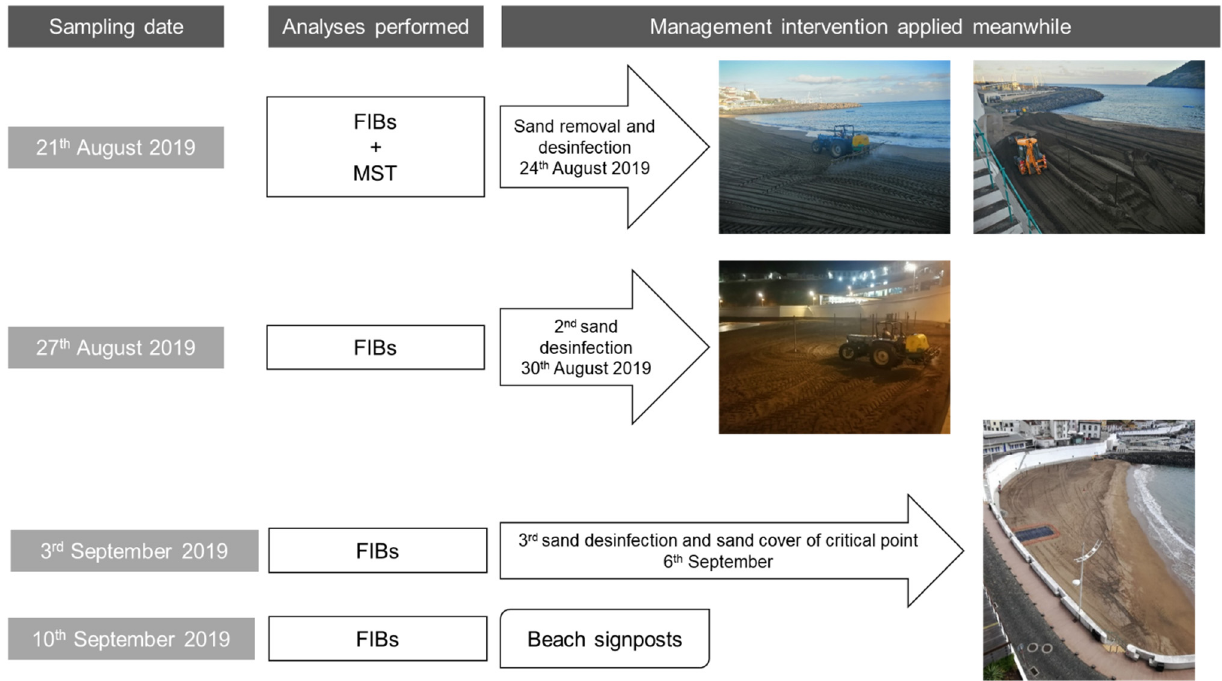
Figure 2. Sampling campaigns and interventions performed throughout the